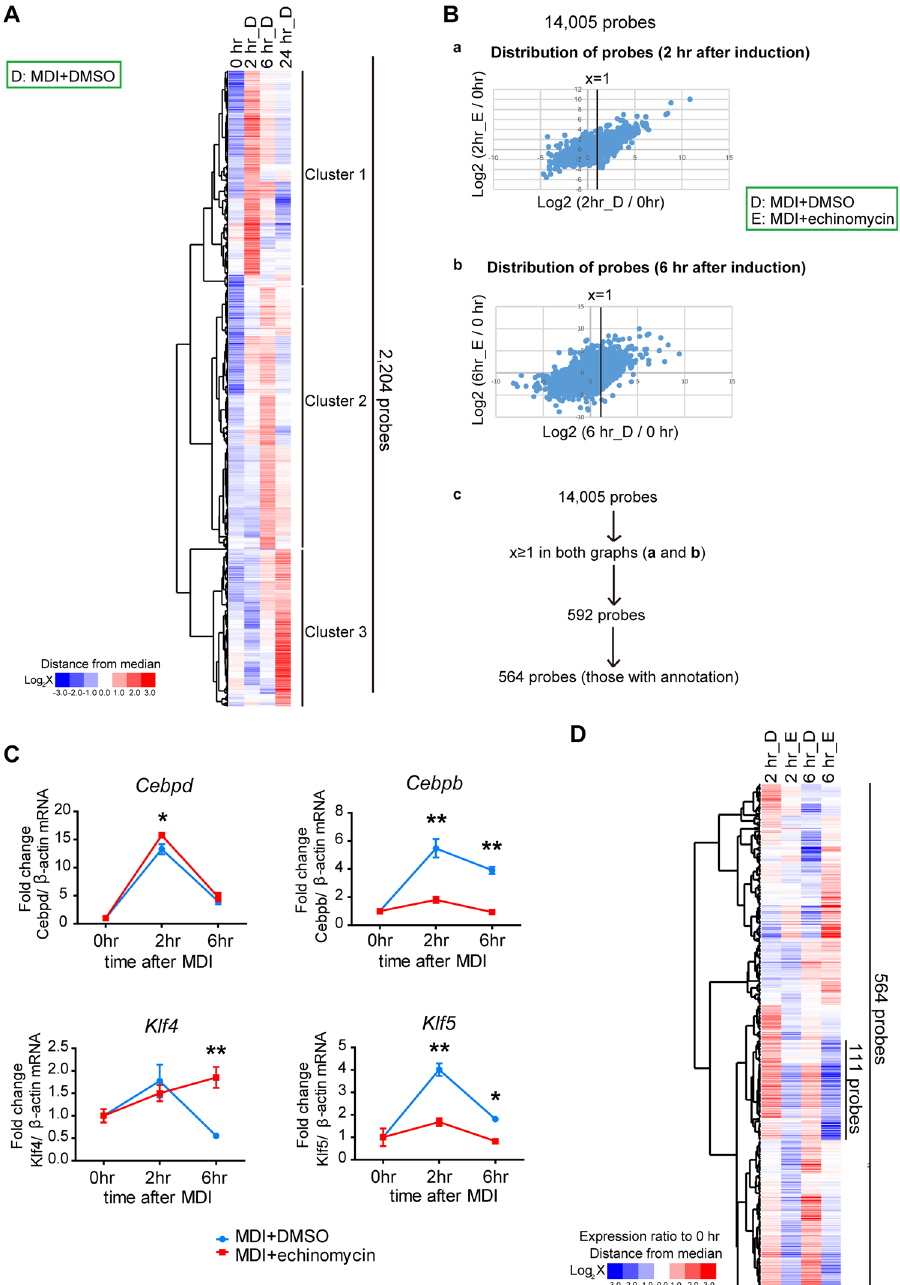
Figure 3. Time-course DNA microarray analysis of 3T3-L1 cells treated with MDI plus DMSO or MDI plus echinomycin. ( A ) Clustering analysis performed among the MDI + DMSO treated groups using 2,204 selected probes that had a fold change ≥ 2.0 in expression compared with the control (0 hr) (See the details in Methods). Genes were clustered into 3 groups according to their timing of response to MDI treatment. ( B ) (a,b) Scatter plot of all the 14,005 probes (signal intensity ≥ 100 at any one point) at 2 hr and 6 hr. A log2-fold change from the control (time 0 hr) of the MDI + echinomycin group is plotted against a log2-fold change from the control (time 0 hr) of the MDI + DMSO group. (c) The scheme of probe selection for further clustering. Genes that had a fold change ≥ 2.0 (x ≥ 1) at both 2 hr and 6 hr relative to time 0 preadipocytes were further analysed using hierarchical clustering. ( C ) Representative quantitative RT-PCR analysis of Cebpb , Cebpd , Klf4 , and Klf5 were performed to validate the microarray analysis. The data are the mean ± SEM of three independent experiments. * P < 0.05, ** P < 0.01, as determined by a two-way ANOVA with Bonferroni’s post-test. ( D ) A heatmap of the expression ratio (compared with 0 hr time point) is shown, and 111 probes are extracted as a cluster containing the genes induced by MDI and suppressed by echinomycin at both 2 hr and 6